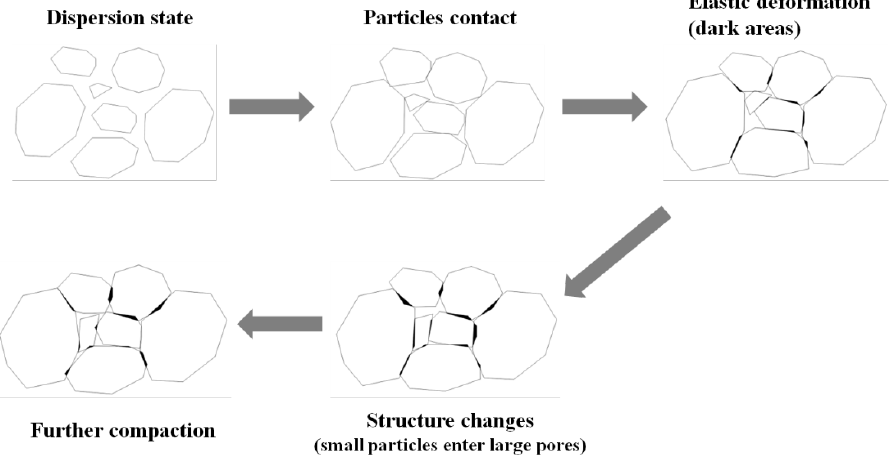
Figure 11. Schematic of mesostructure changes in tailings particles.